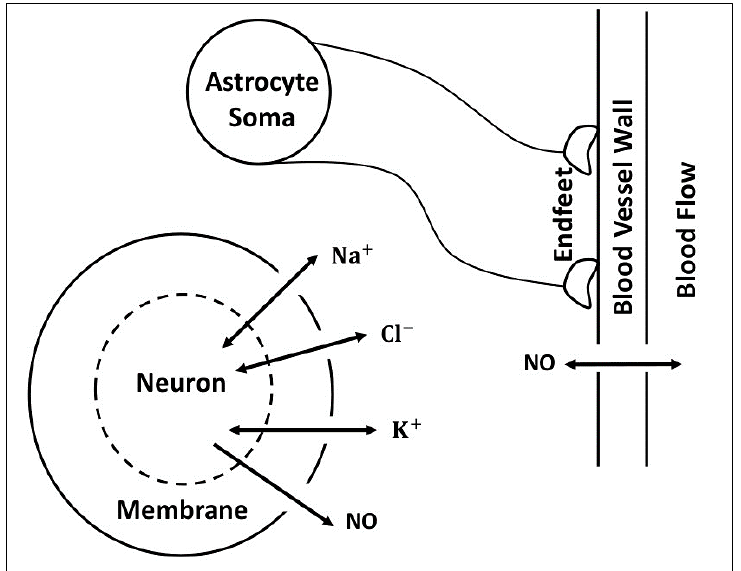
Figure 1. A drawing of the neuro-glial-vascular unit showing only the structure and components of interest to this work. Astrocyte’s endfeet use NO (among other chemical species) to control opposite vasomotor responses. The diffusive NO is produced by neurons, endothelial and red blood cells. An action potential (the fast moving of 𝑵𝒂 + , 𝑲 + , and 𝑪𝒍 − across neuronal membrane) due to an externally applied current affects the production of neuronal NO and causes a mechanical deformation of the neuron. Because of the very close proximity of the neuron and astrocyte, the mechanical deformation of the neuron triggers a mechanical movement of astrocyte’s endfeet. (Drawing inspired by diagrams published in [1, 4-5] that depict various biological pathways facilitating the functions of the neuro-glial-vascular